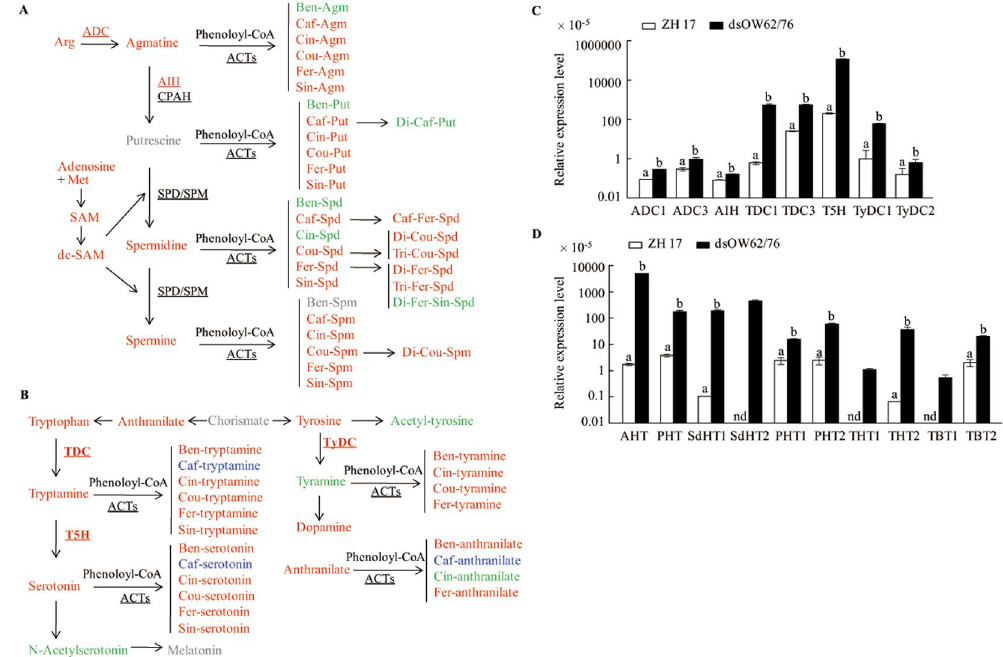
Figure 4. Enhanced accumulation of phenolamides derived from aliphatic ( A ) and aryl ( B ) amines and upregulation of the related genes ( C , D ) in dsOW62/76 plants. ( A ) Polyamines (PAs) and agmatine can be conjugated with phenoloyl-CoA to form phenolamides. Similarly, the arylamines derived from chorismate can be converted to phenolamides ( B ). The font colors and shapes represent the same meanings as described in Fig. 1. Transcription levels of the genes for amine generation ( C ) and for phenolamide formation ( D ) were analyzed. Data are means ± SE of three replicates. A rice ubiquitin gene was used as the internal standard for qPCR analysis. Values marked with different letters indicate statistically significant differences as analyzed by SAS software (Duncan’s multiple range test, α = 0.05). nd for not detected. Abbreviations: Agm, Put, Spd, and Spm for agmatine, putrescine, spermidine, and spermine, respectively; Ben, Caf, Cin, Cou, Fer, and Sin for benzoyl, caffeoyl, cinnamoyl, coumaroyl, feruloyl, and sinapoyl, respectively; dc-SAM decarboxylated S-adenosylmethionine; SAM S-adenosylmethionine; ACTs, N -acyltransferases, in which AHT, PHT, SdHT, and THT for Agm, Put, Spd, and tryptamine hydroxycinnamoyl transferases, respectively and TBT for tryptamine benzoyl transferase; ADC, arginine decarboxylase; AIH, agmatine iminohydolase; CPAH, N-carbamoylputrescine amidohydrolase; SPD/SPM, spermidine/spermine synthase; T5H, trytamine 5-hydroxylase; TDC, tryptophan decarboxylase; TyDC, tyrosine